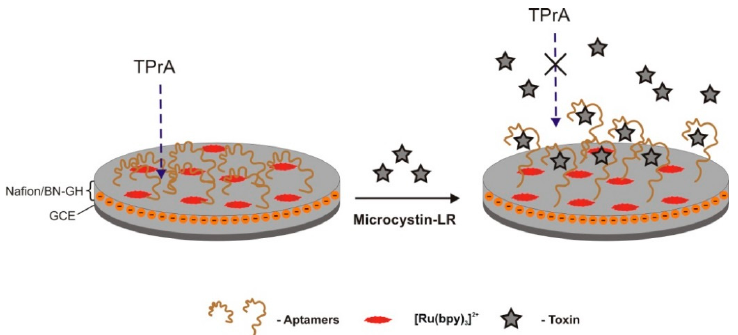
(TPrA) to tris (2,2 (cid:48) -bipyridine) ruthenium (2+) ion (Ru(bpy) 32+ ) of the glassy carbon electrode (GCE) interface that results in an intense decrease in electrochemiluminescence